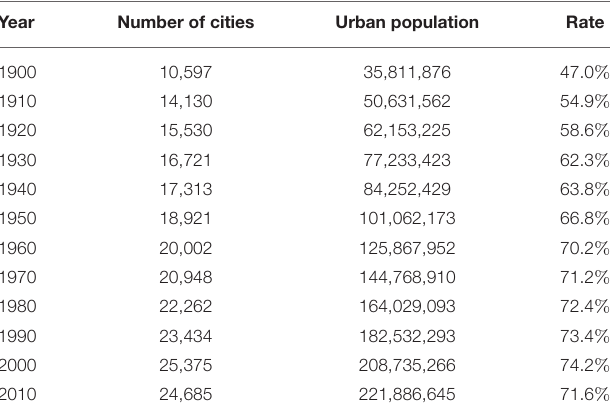
TABLE 1 | Summary of U.S. population